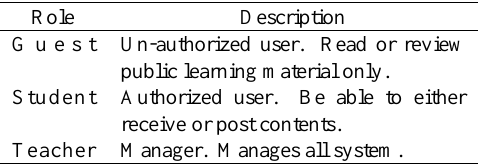
Table 1. Description of role